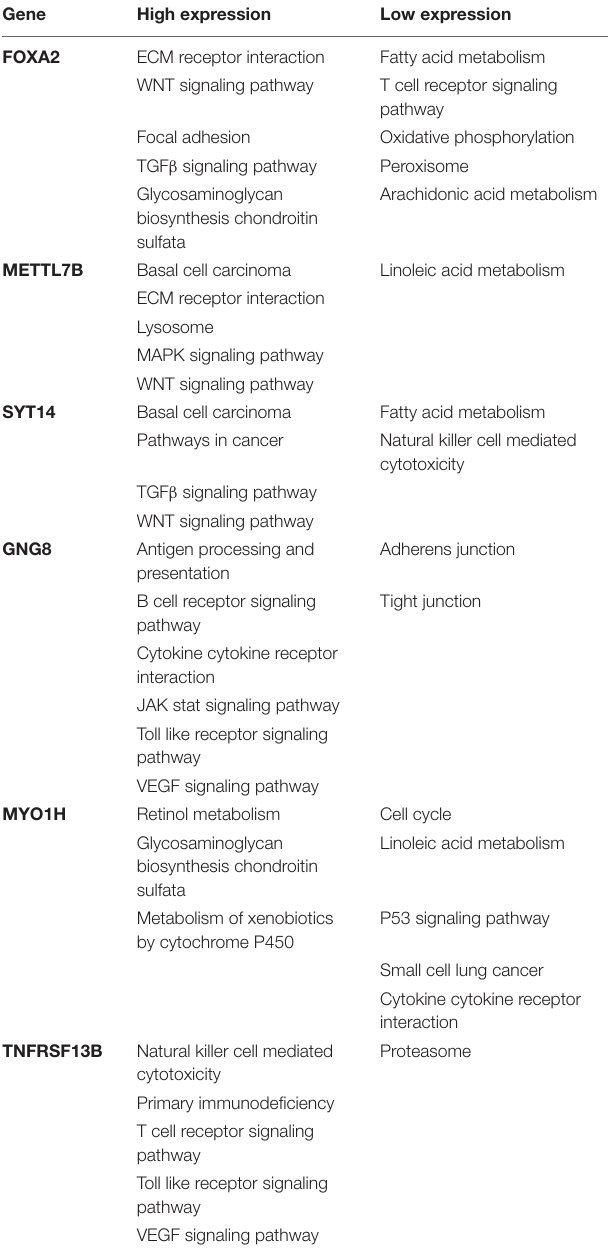
TABLE 4 | Single-gene GSEA in FOXA2, METTL7B, SYT14, GNG8, MYO1H, and TNFRSF13B.